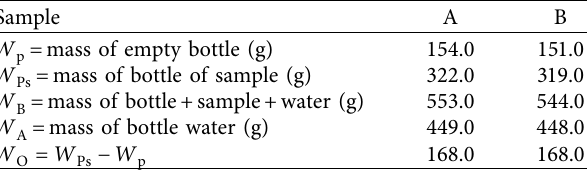
Table 6: Specifc gravity values of fne aggregate.